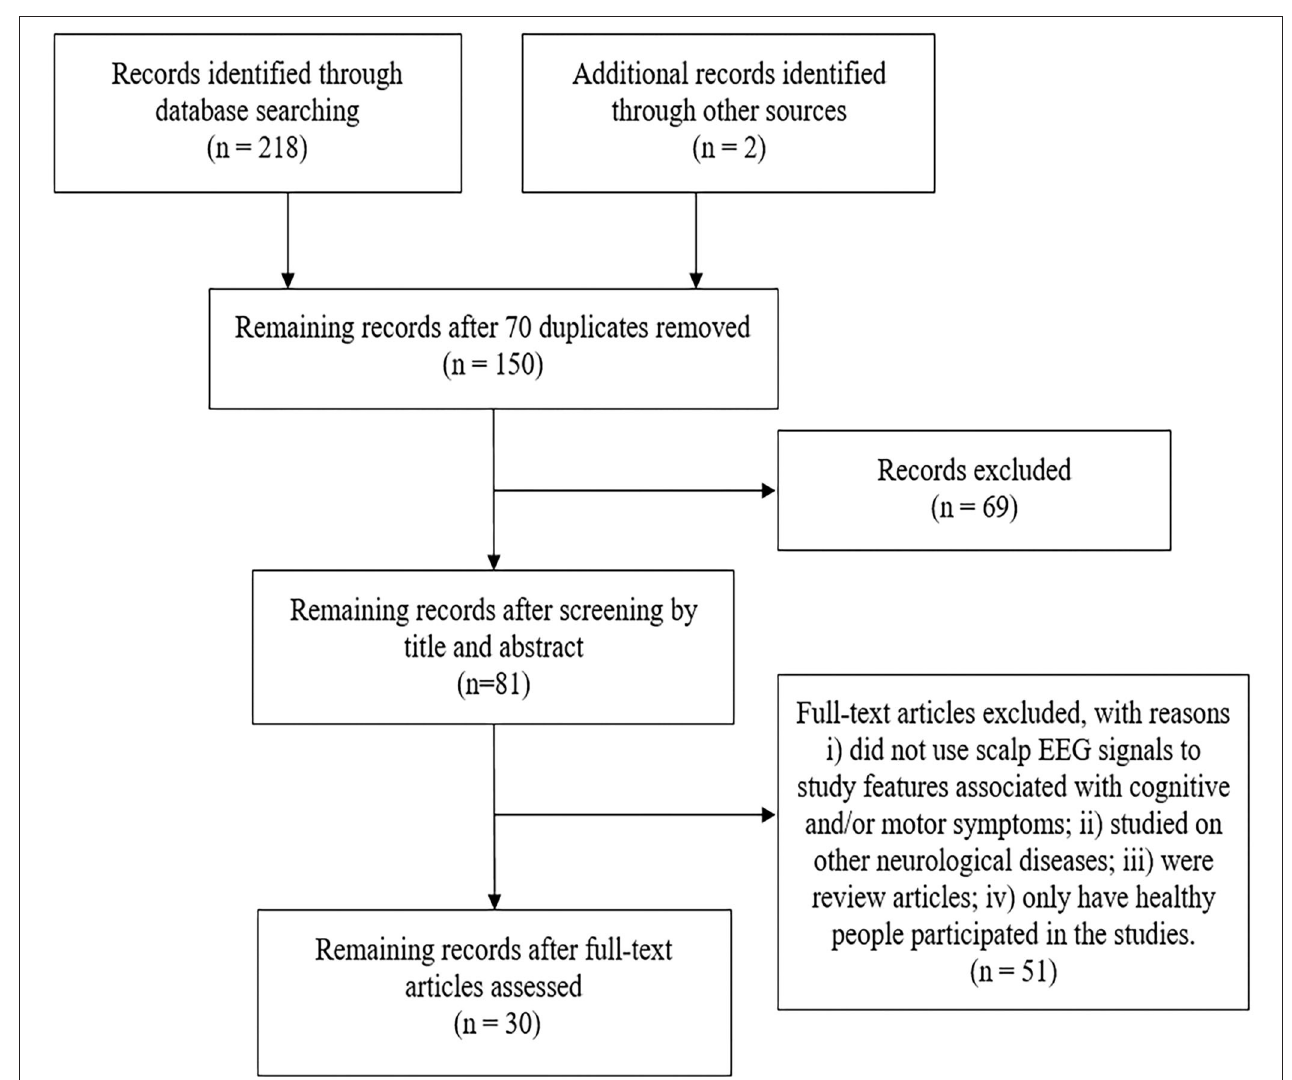
FIGURE 1 | The modified PRISMA flow diagram through the selection of